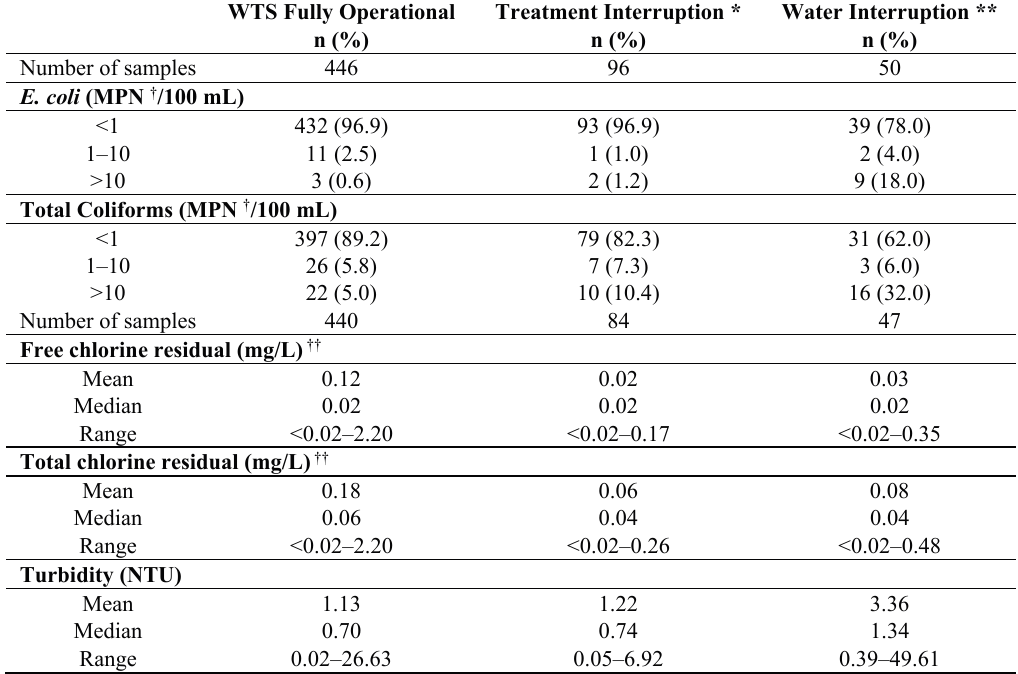
Table 2. Quality of water from samples collected at points of use when water treatment systems were fully operational, during treatment interruptions, and water